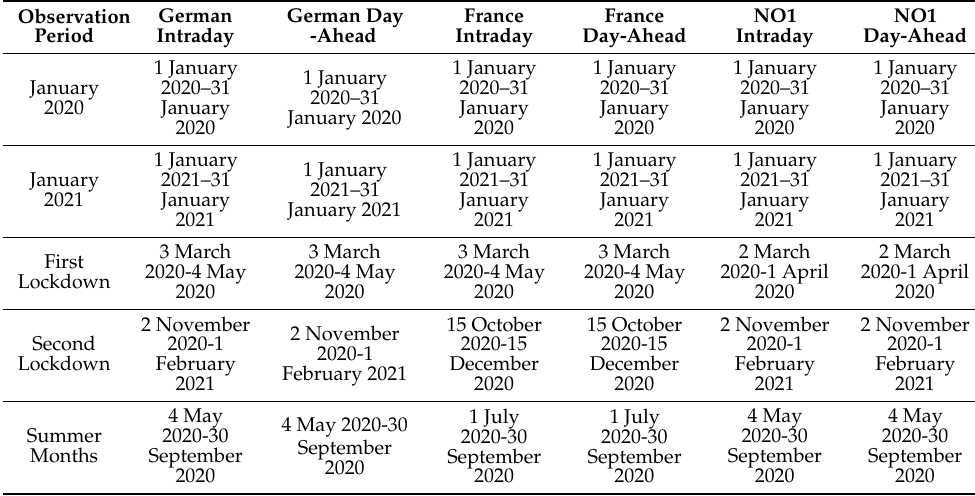
Table 2. Data for the statistical evaluation on electricity prices. Observation Period